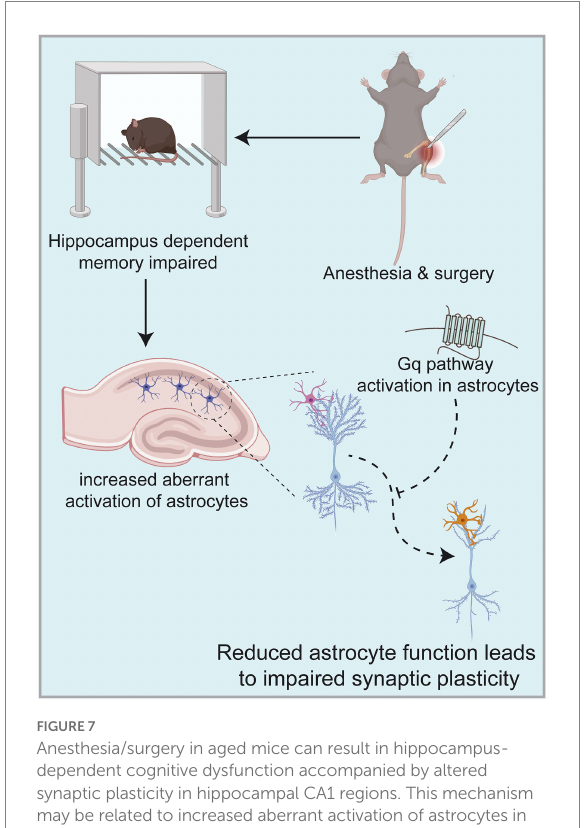
FIGURE 7 Anesthesia/surgery in aged mice can result in hippocampus- dependent cognitive dysfunction accompanied by altered synaptic plasticity in hippocampal CA1 regions. This mechanism may be related to increased aberrant activation of astrocytes in the hippocampus, among which astrocytes are known to be active participants in synaptic processing. In contrast, activation of Gq pathways in hippocampal astrocytes improves hippocampal-dependent cognitive dysfunction. Images were created on the BioRender web